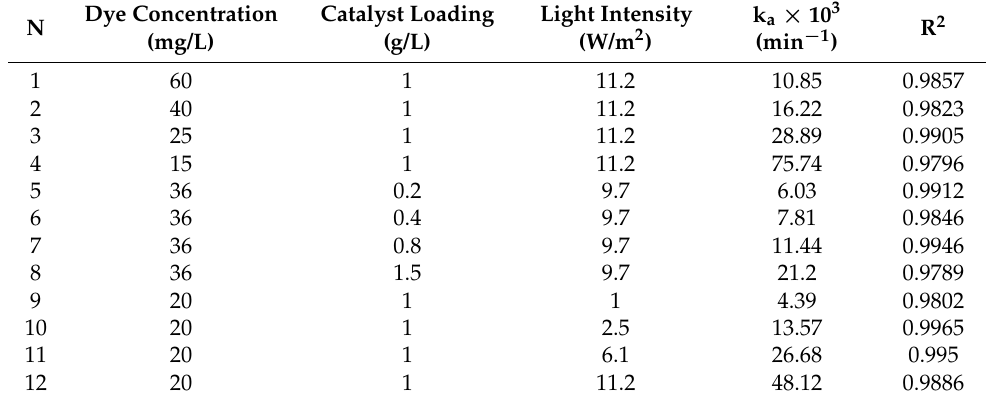
Figure 6. Kinetics of DB15 degradation at different dye concentrations (pH 4, catalyst loading 1 g/L, and light intensity 11.2 W/m 2 ). Table 1. Kinetics data obtained at pH 4 and different reaction conditions.